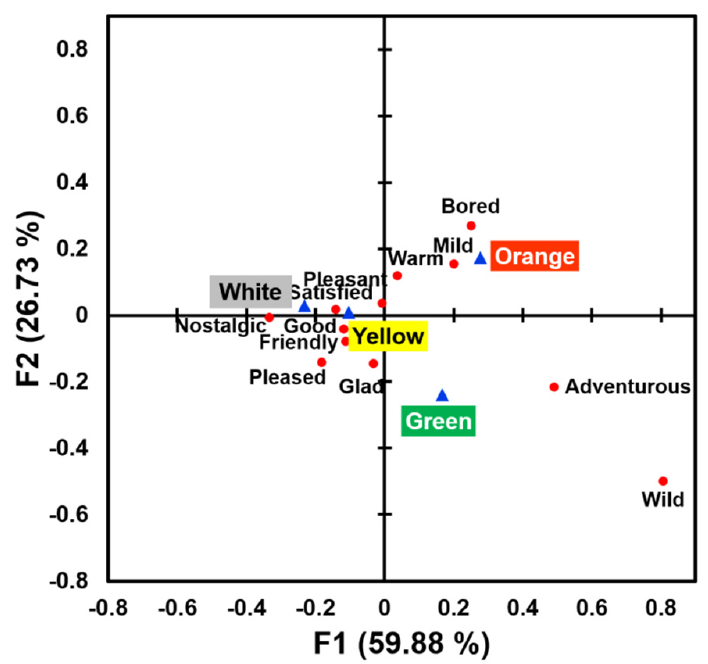
Figure 5. A bi-plot of the correspondence analysis in the associations of color cues (blue triangles) with emotion attributes (red circles) in the cooked rice samples varying in surface colors: white, yellow, orange, and green. Multiple pairwise comparison tests using the McNemar (Bonferroni) procedure further revealed how surface colors can be associated with di ff erent emotional attributes of cooked rice samples. As shown in Table 3, the “bored” emotion was evoked more frequently in response to the orange color sample than the green color sample, and the “friendly” emotion was more frequently evoked toward the yellow color sample than the orange color sample. While the white color sample more frequently evoked positive emotions such as “good”, “pleased”, “satisfied”, and “pleasant” than the yellow, orange, or green color sample, the green color sample was not exceptional in evoking specific emotional attributes when compared to other color samples.